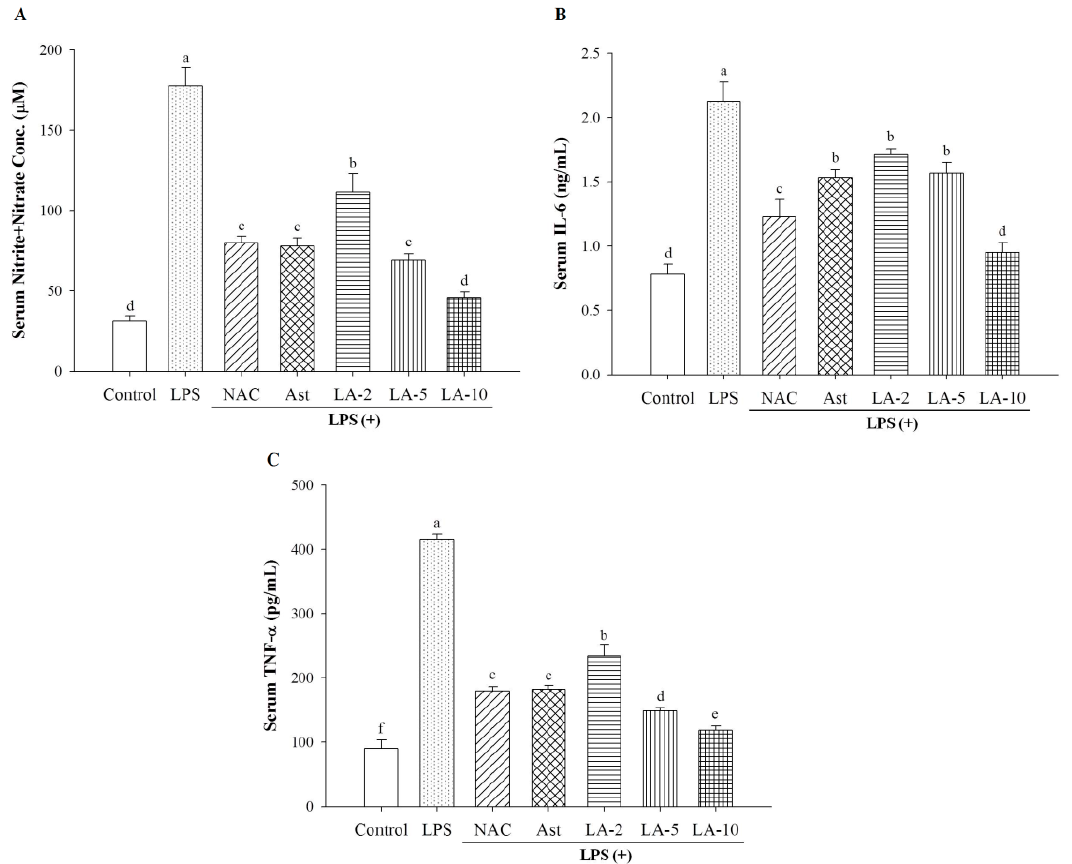
Figure 3. Nitric oxide ( A ), interleukin-6 (IL-6) ( B ) and tumor necrosis factor- α (TNF- α ) ( C ) levels in the serum. Each bar represents the mean ± SEM ( n = 6). Statistical significance was determined using the one-way ANOVA with Tukey-Kramer post-hoc test. Different lower-case letters indicate statistically significant differences ( p < 0.05). NAC, N -acetyl cysteine (200 mg/kg); LPS, lipopolysaccharide; LA-2, -5 and -10, liposomal AST at 2, 5 and 10 mg/kg BW, respectively.